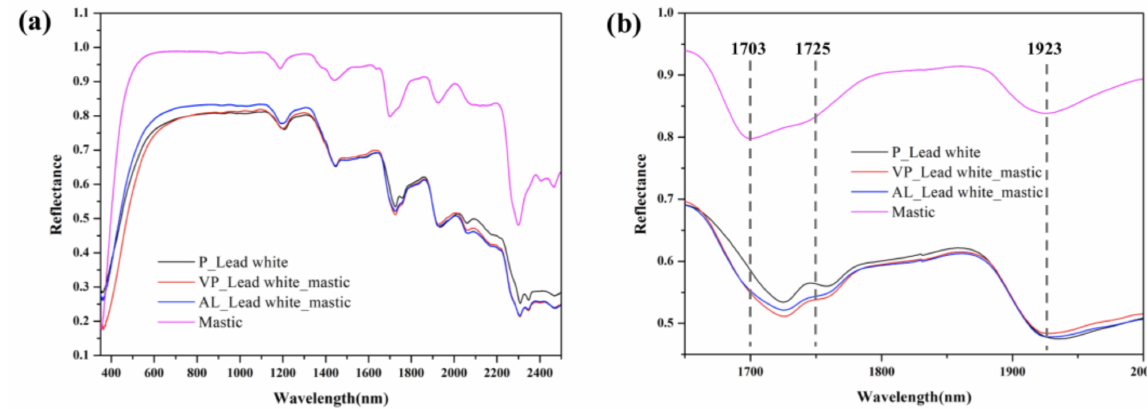
Figure 8. The full range reflectance spectrum ( a ) and the selected region reflectance spectrum ( b ) of pure mastic, lead white tempera mock-up (P), lead white tempera varnished with mastic (VP) and mock-up after laser cleaning (AL). All spectra reported were collected in Section 8 of painting mock-ups (Figure 1).